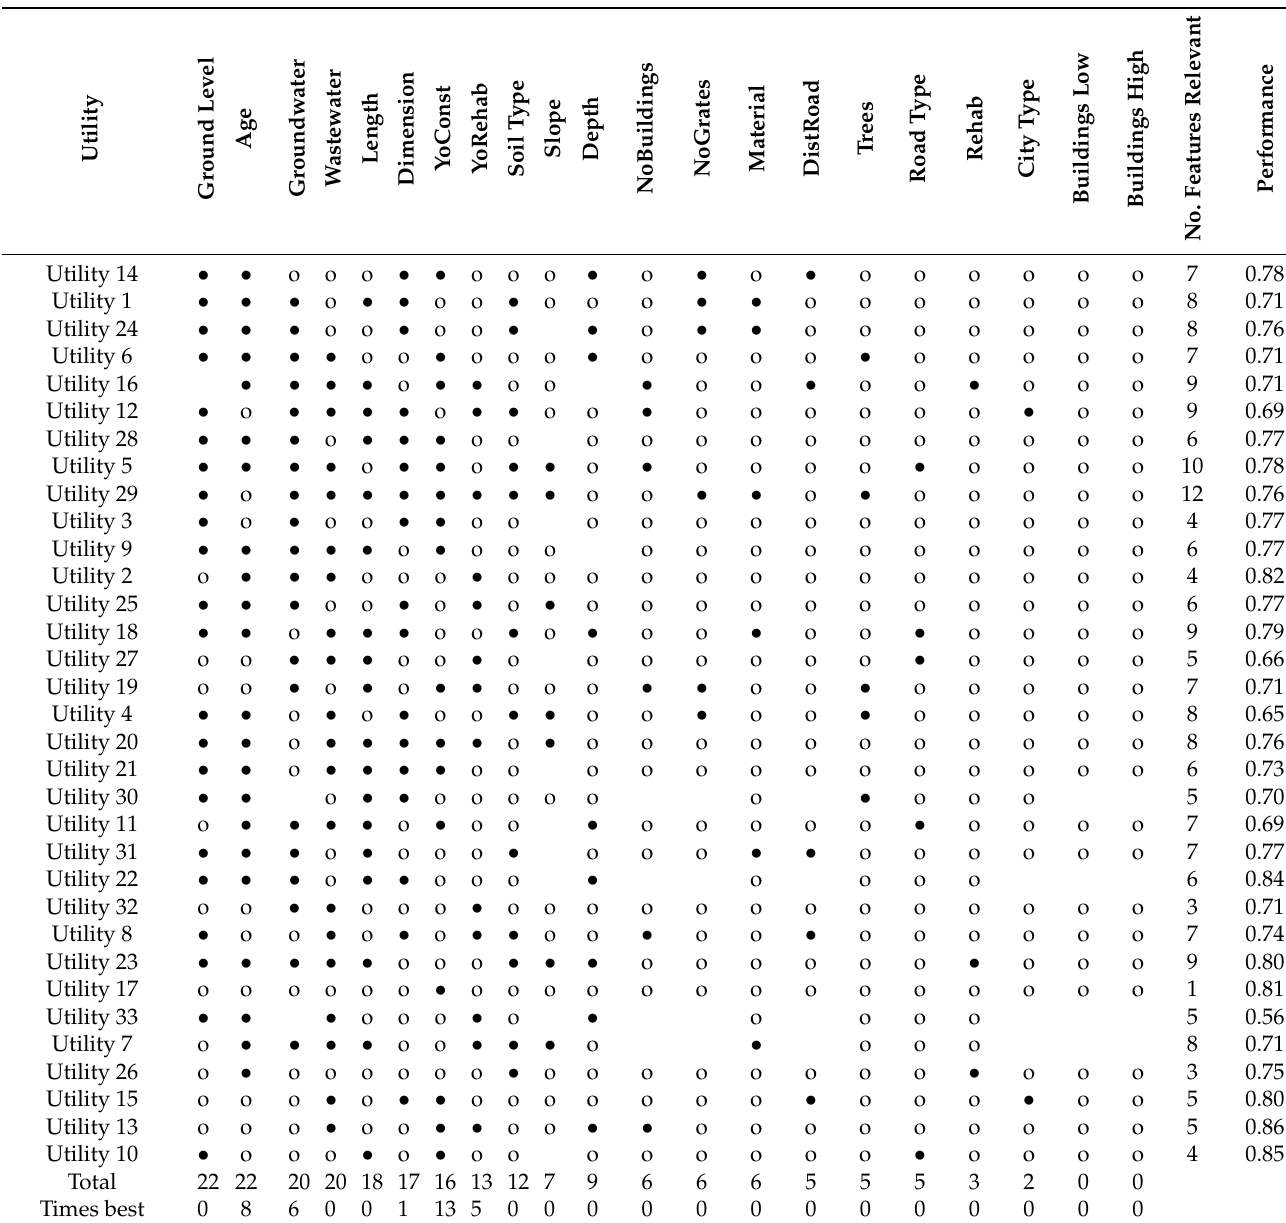
Table 4. Overview of which predictor variables contribute to the model performance for each utility. A “ • ” shows that the predictor variable contributes to the performance, a “o” shows that the predictor variable was included in the analysis but did not contribute to the model performance. The features are sorted in descending order, according to how often they contribute to the performance, and the utilities are sorted in descending order, according to number of pipes in CS 4. In addition, this table includes an overview of the most important feature and the best performance obtained for each